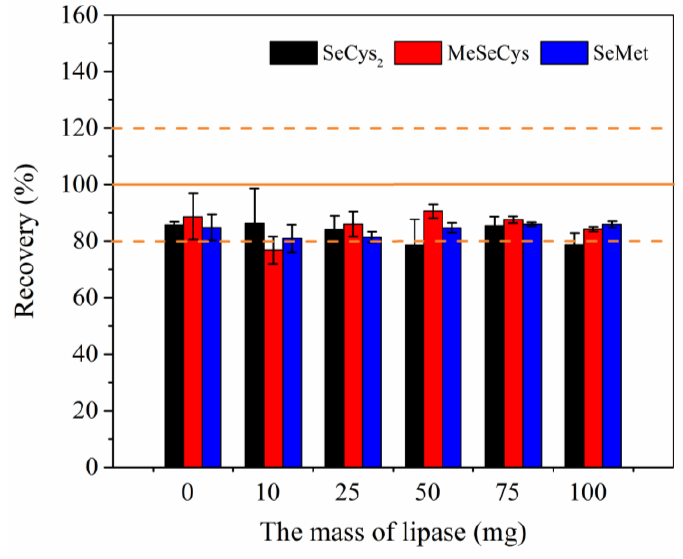
Figure 4. Spike recoveries of three Se species with different lipase usage. Solid line represents the spike recovery value of 100%. Dash lines represent spike recovery range between 80% and 120%.